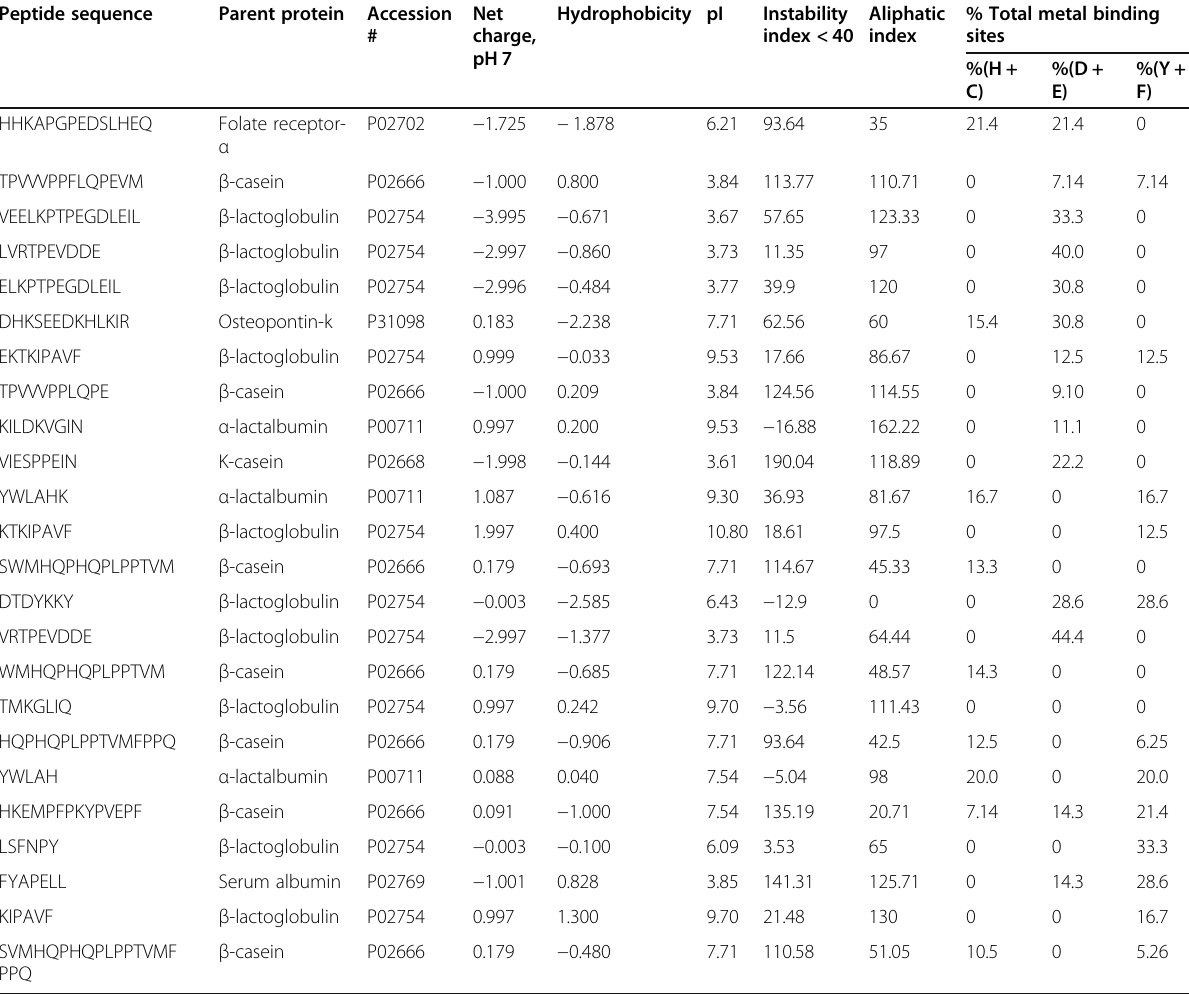
Table 1 Sequence, physicochemical properties and metal ligand content of zinc-binding peptides derived from whey protein hydrolysate Peptide